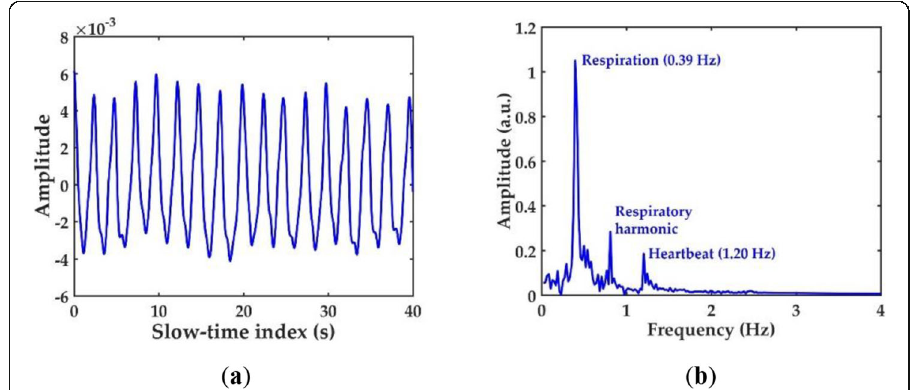
Fig. 4 A typical spectrum of fast Fourier transform (FFT) of a preprocessed human signal at the target position. a The preprocessed human signal at the target position. b Corresponding spectrum of FFT. a.u., arbitrary